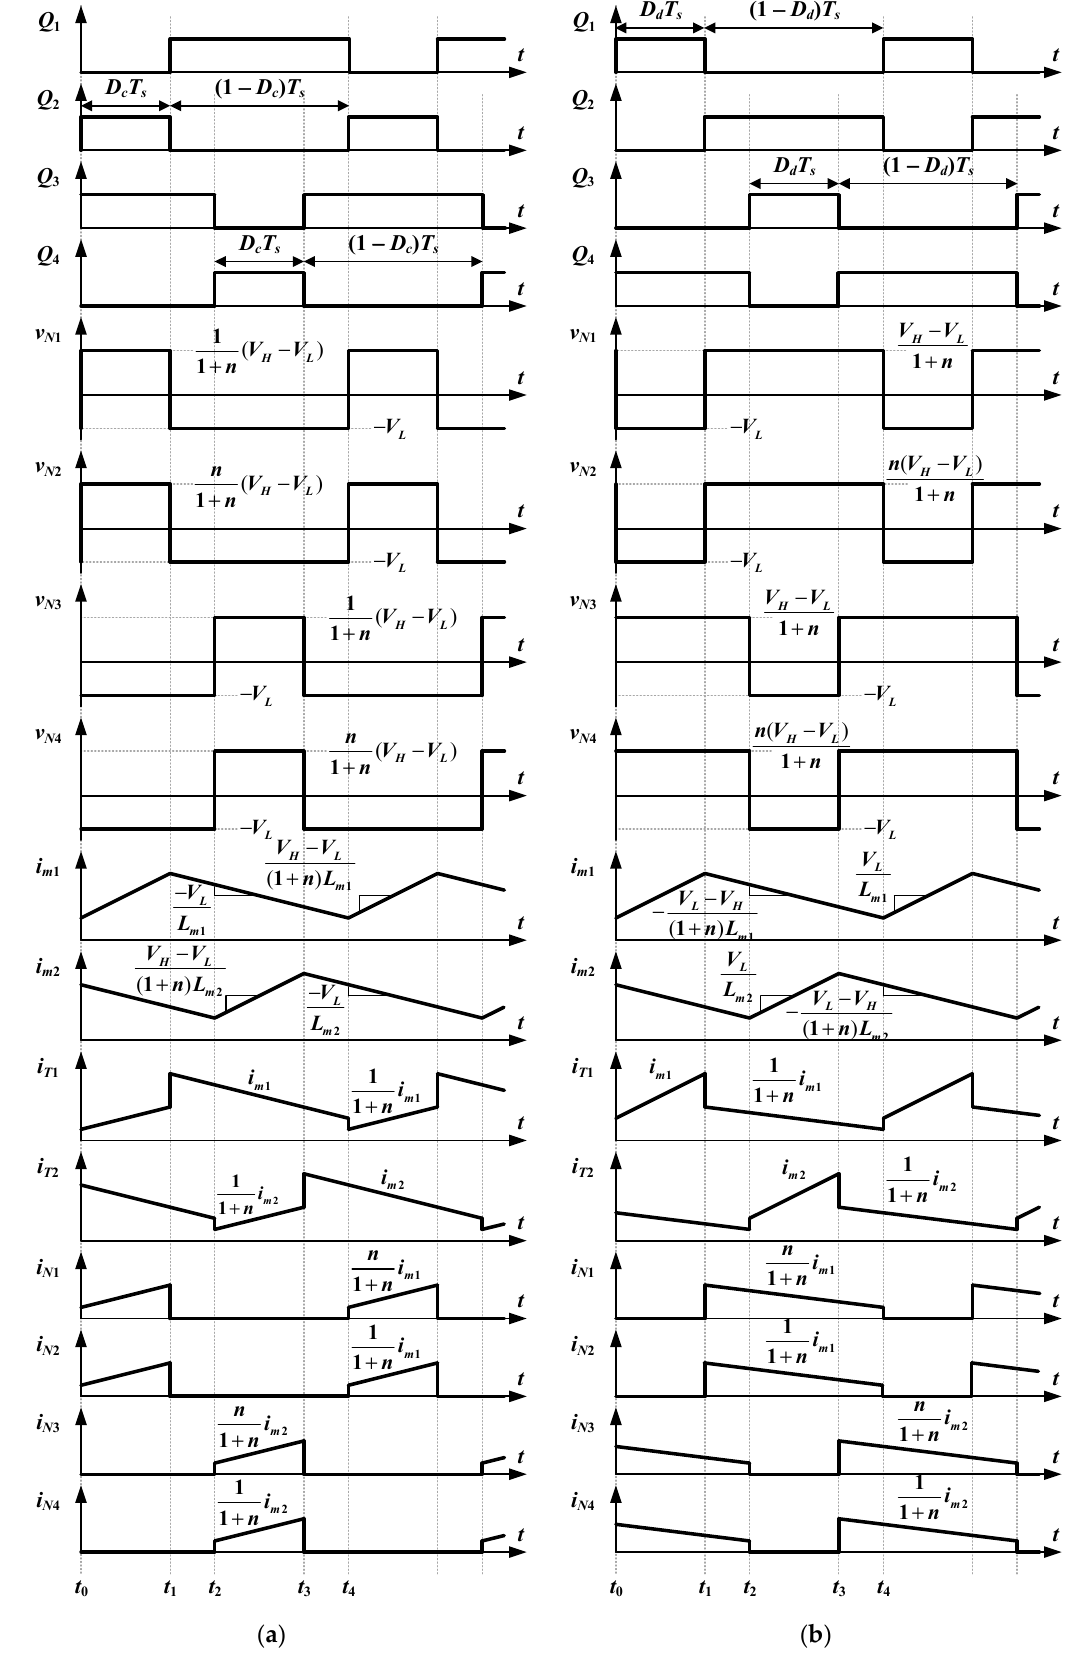
Figure 6. Key waveforms: ( a ) charge mode and D c < 0.5; ( b ) discharge mode and D d < 0.5.